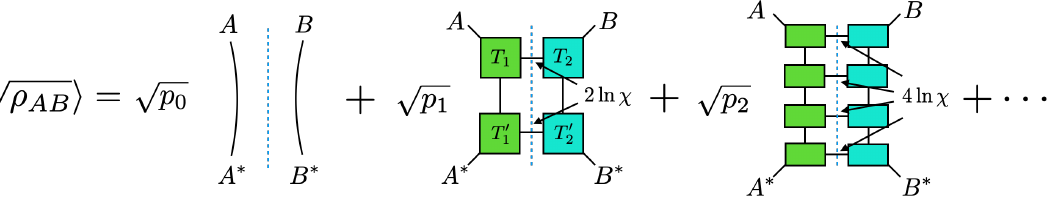
Figure 15 . An illustration of eq. (4.53). The canonical purification | ρ AB i is effectively described by a superposition of tensor network states. For k = 0 we have the factorized state with zero cross-section. To form the k > 0 sectors we start from a simple network state made from two copies of the 2TN state. Then for each k we glue together k such states, resulting in a TN with total cross-sectional area 2 k ln χ , as indicated by the number of bonds cut by blue dashed lines. This figure should be compared to figure 3, where each effective TN corresponds to a genus- (2 k − 1) bulk solution of the replica boundary